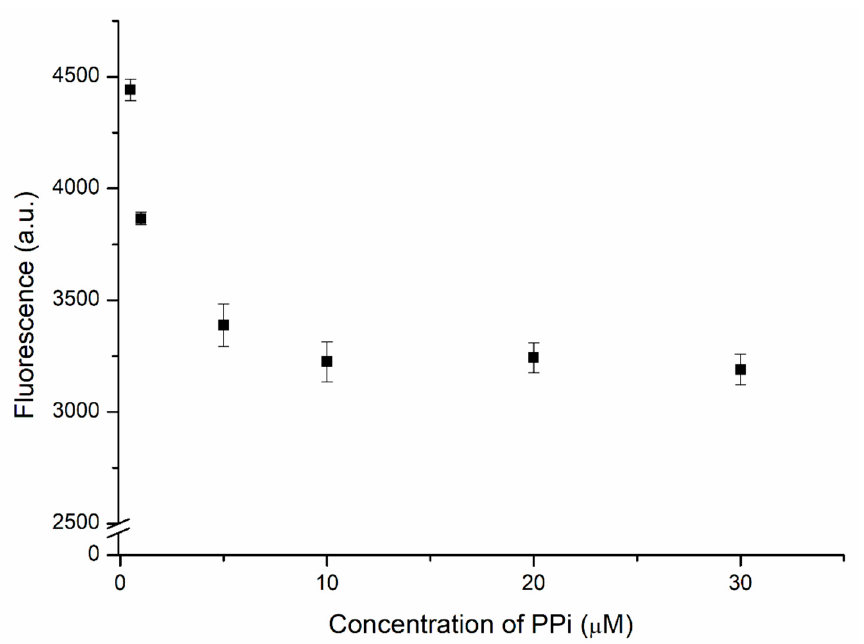
Figure 5. Fluorescence intensity of the DNAzyme complex (30 nM) in the presence of 1 µ M of Cu 2+ and PPi at various concentrations.